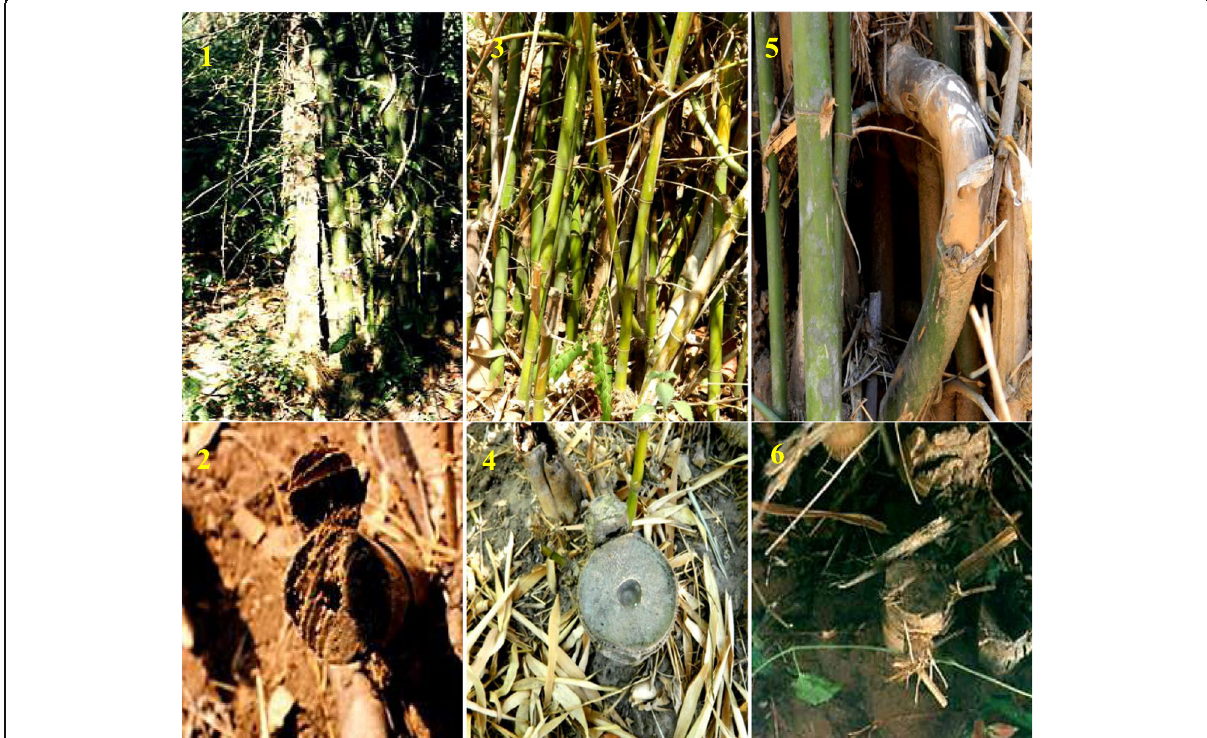
Fig. 3 Clump nature and internal culm structure of Dendrocalamus strictus growth forms growing at different locations in Uttarakhand. Open, straight bamboo clump (1,2) and hollow bamboo culm at FRI campus (Site-F), partially closed, intertwined clump (3,4) and partially hollow culm at Byasi, Shivpuri range (Site-S) and closed, highly intertwined clump (5,6) and solid clump at Chiriapur range (Site-C). Source: Rawat, 2005